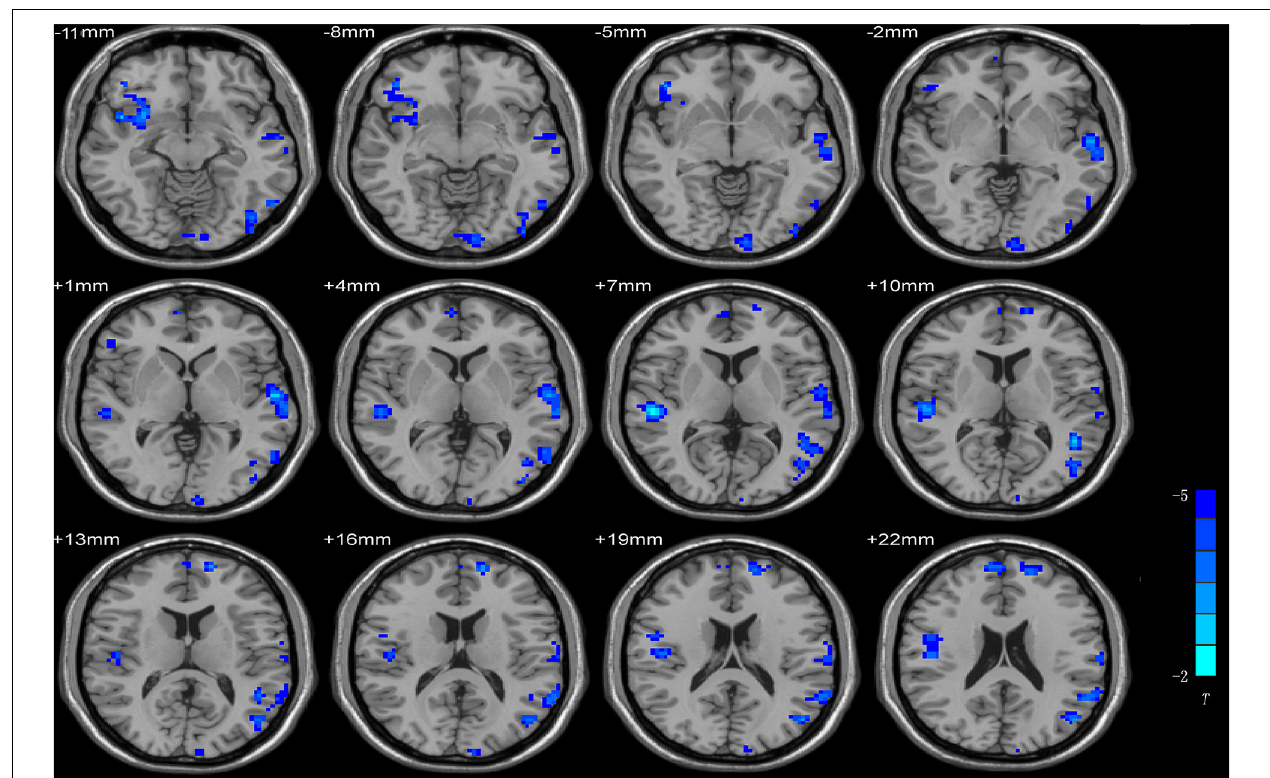
FIGURE 1 | Brain areas with increased and decreased ReHo in post-scan compared with pre-scan. Pair-sample t -test p < 0.05, AlphaSim corrected, voxel size = 3 × 3 × 3; T -score bars are shown on the right bottom. The voxels with hot colors represent increased ReHo after training, and cold colors indicate decreased ReHo after